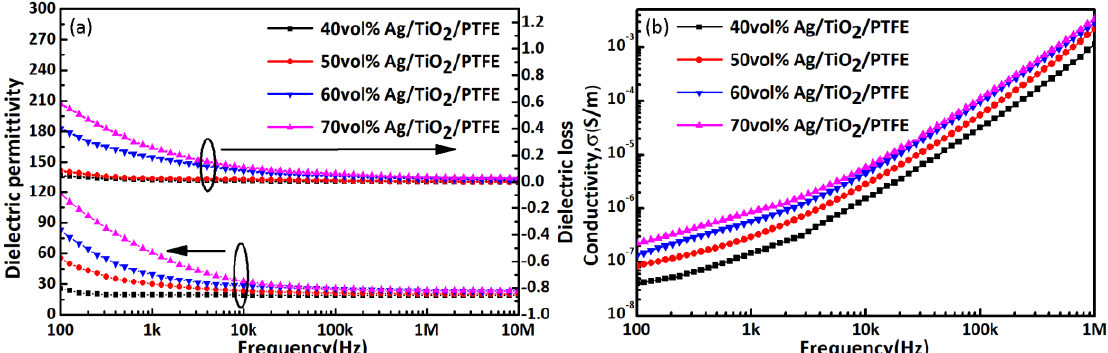
Figure 7. Frequency dependence of ( a ) dielectric performance and ( b ) conductivities σ for Ag/TiO 2 /PTFE nanocomposites containing PFBPA-modified Ag/TiO 2 fillers at varying volume fractions at room temperature.